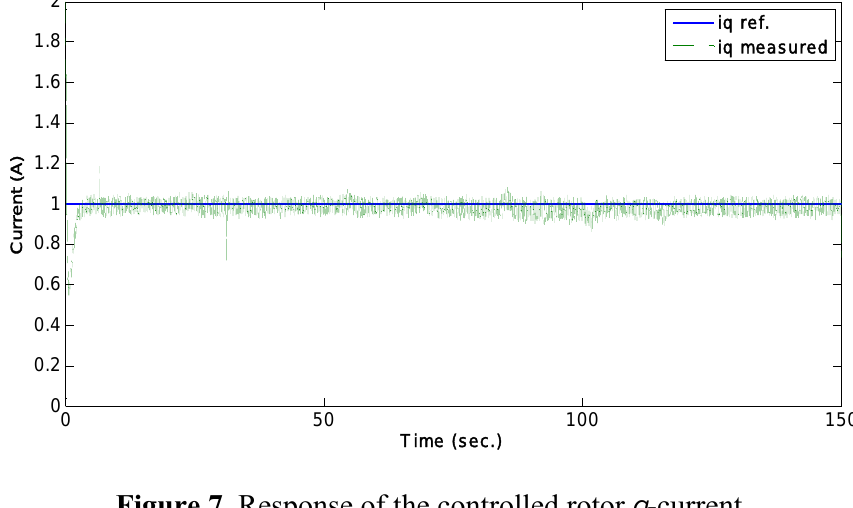
Figure 7. Response of the controlled rotor q -current.